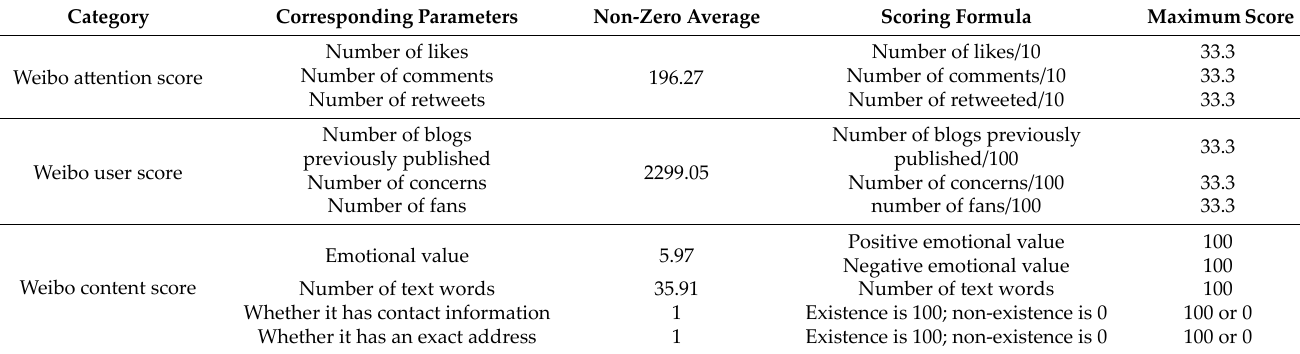
Table 4. Microblog usefulness dimensions and their parameter settings.